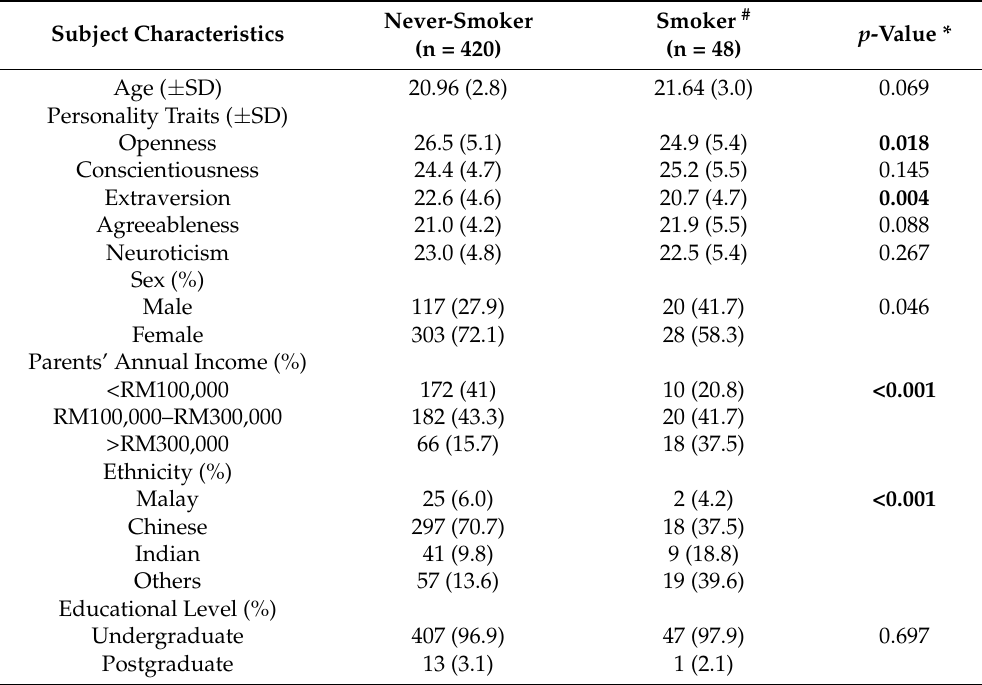
Table 1. Demographic characteristics and personality traits score of study participants.